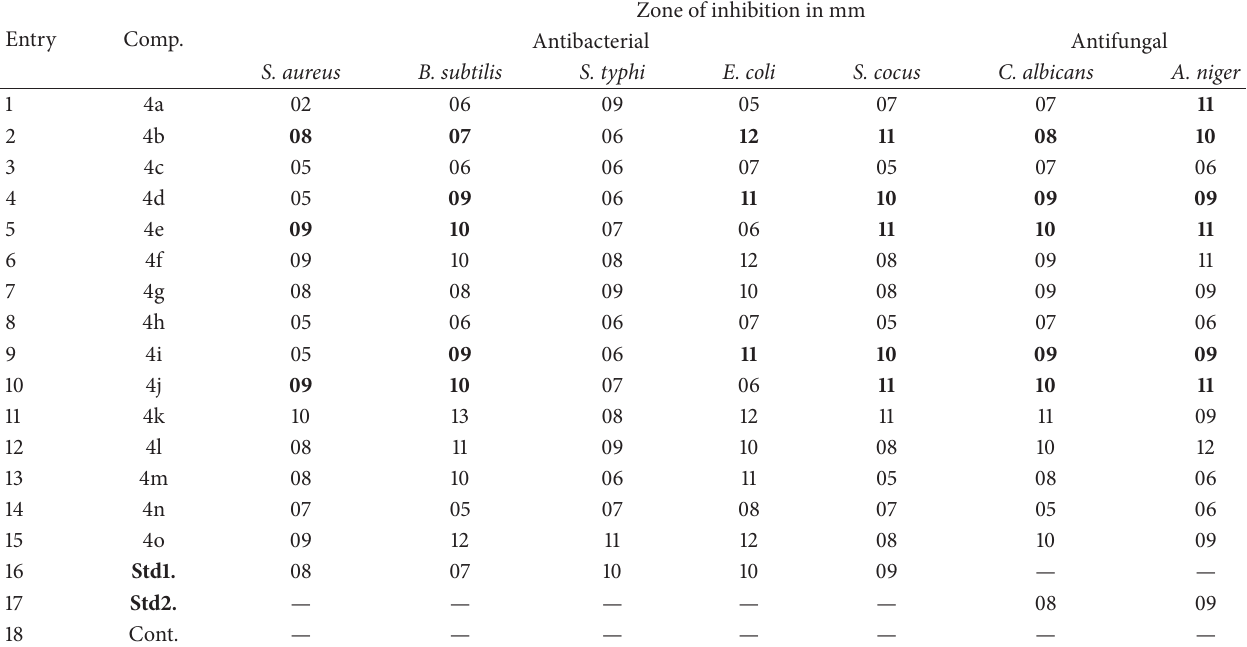
Table 3: Antimicrobial